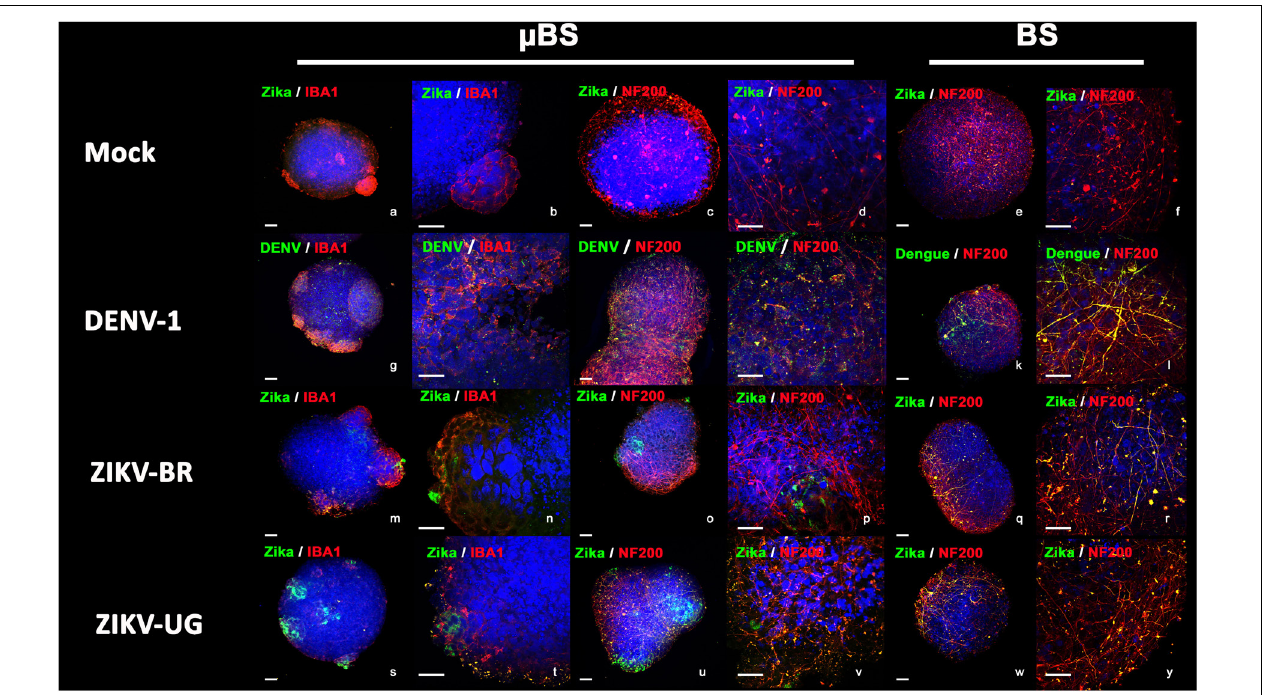
FIGURE 3 | Virus infection in BrainSpheres. Figure shows virus infection by immunohistochemistry in BrainSpheres with ( µ BS) and without microglia (BS). Green represents the Flavivirus marker for ZIKV ( NS1 ) and DENV-1, red represents microglia markers IBA1 and NF200 . Bars represent 50 µ m (lower magnification) and 10 µ m (higher